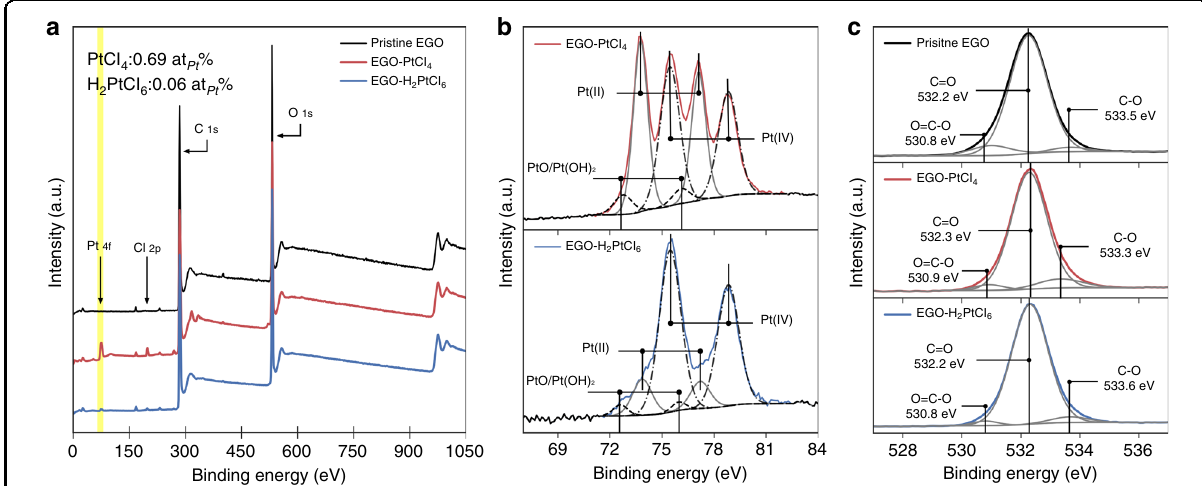
Fig. 3 XPS characterization of the pristine EGO, and PtCl 4 (5 mM) and H 2 PtCl 6 (5 mM) fi ltered EGO fi lms. a XPS survey, b high-resolution XPS Pt 4f spectra, and c O 1 s